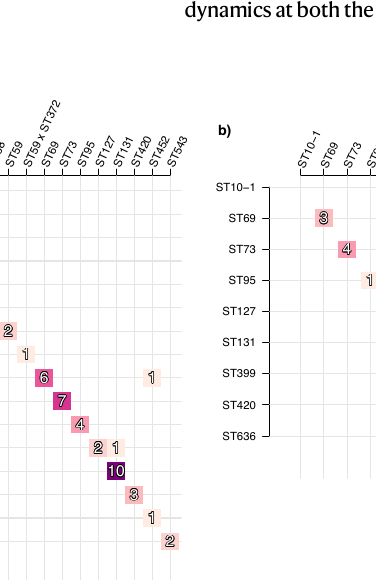
Fig. 5 | Event matrix displaying colonisation identities with respect to E. coli lineages between subsequent time points. The fi gure shows events corre- sponding to either transition from one E. coli lineage (rows) to another E. coli lineage (columns) or persistence of the same lineage (diagonal). a Events for the vaginal delivery cohort with samples from the infancy period excluded, and